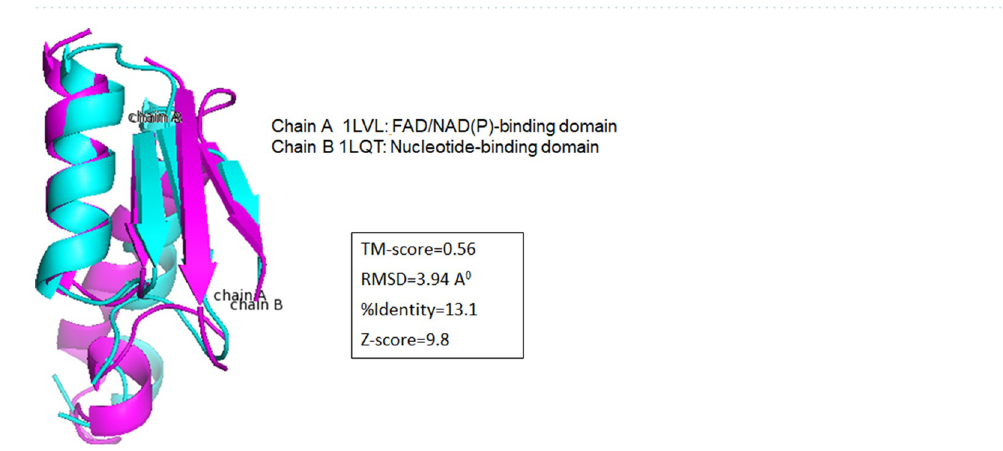
Figure 7. Alignment of three-dimensional structures of local regions of the domains from two different folds FAD/NAD(P)-binding domain (Chain A: PDB code 1LVL) and Nucleotide-binding domain (Chain B: PDB code 1LQT) using